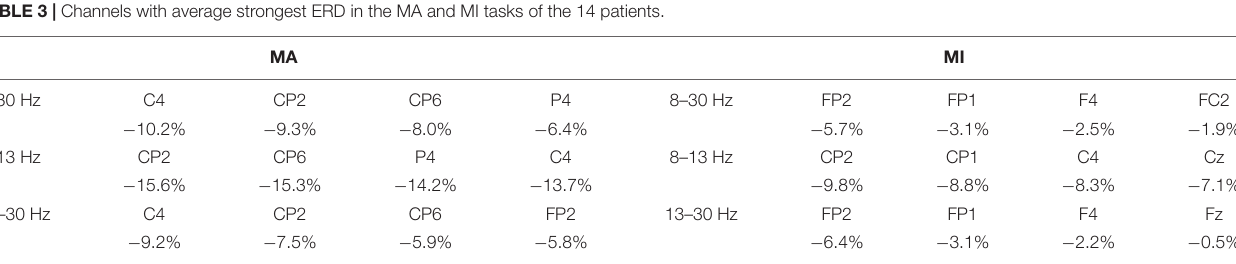
FIGURE 4 | The ERD pattern changes over time of one patient with left hemisphere injury during the motor tasks. The ERD was presented in the red rectangular box in 8–30 Hz frequency bands in channels C3 and C4 of the MA task (A) and 8–13 Hz frequency bands in channels C3 and C4 of the MI task (B) . TABLE 3 | Channels with average strongest ERD in the MA and MI tasks of the 14